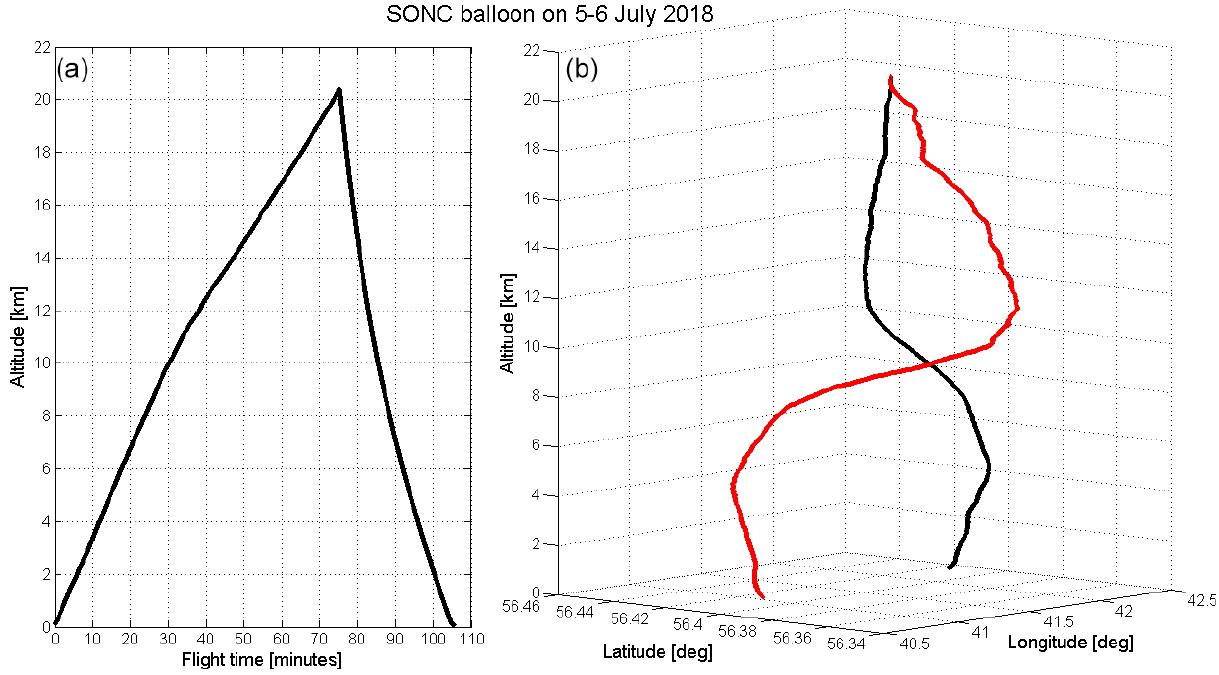
Figure 2. (a) The altitude of the SONC balloon as a function of flight time. (b) The vertical–horizontal trajectories of the SONC balloon: the red line is the upleg trajectory and the black line is the downleg trajectory.